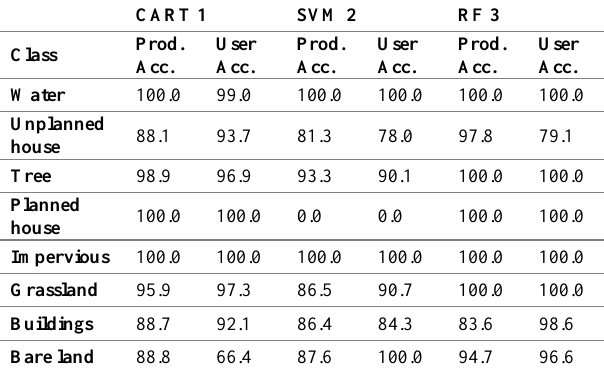
Table 3. Summary of confusion matrix of each finest classifier. Class